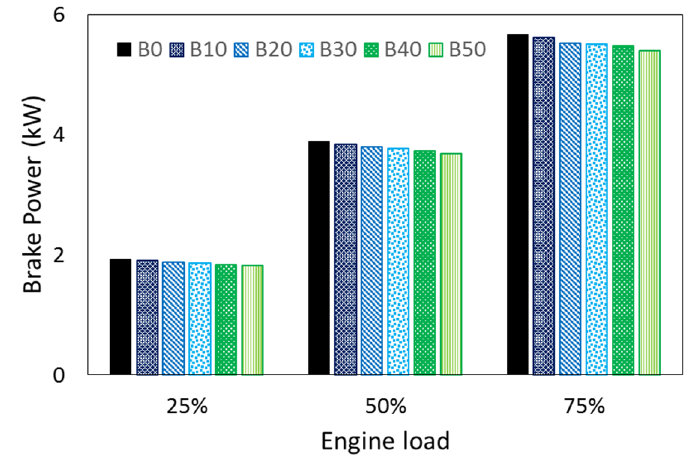
Figure 3. Effect of biodiesel on engine power.